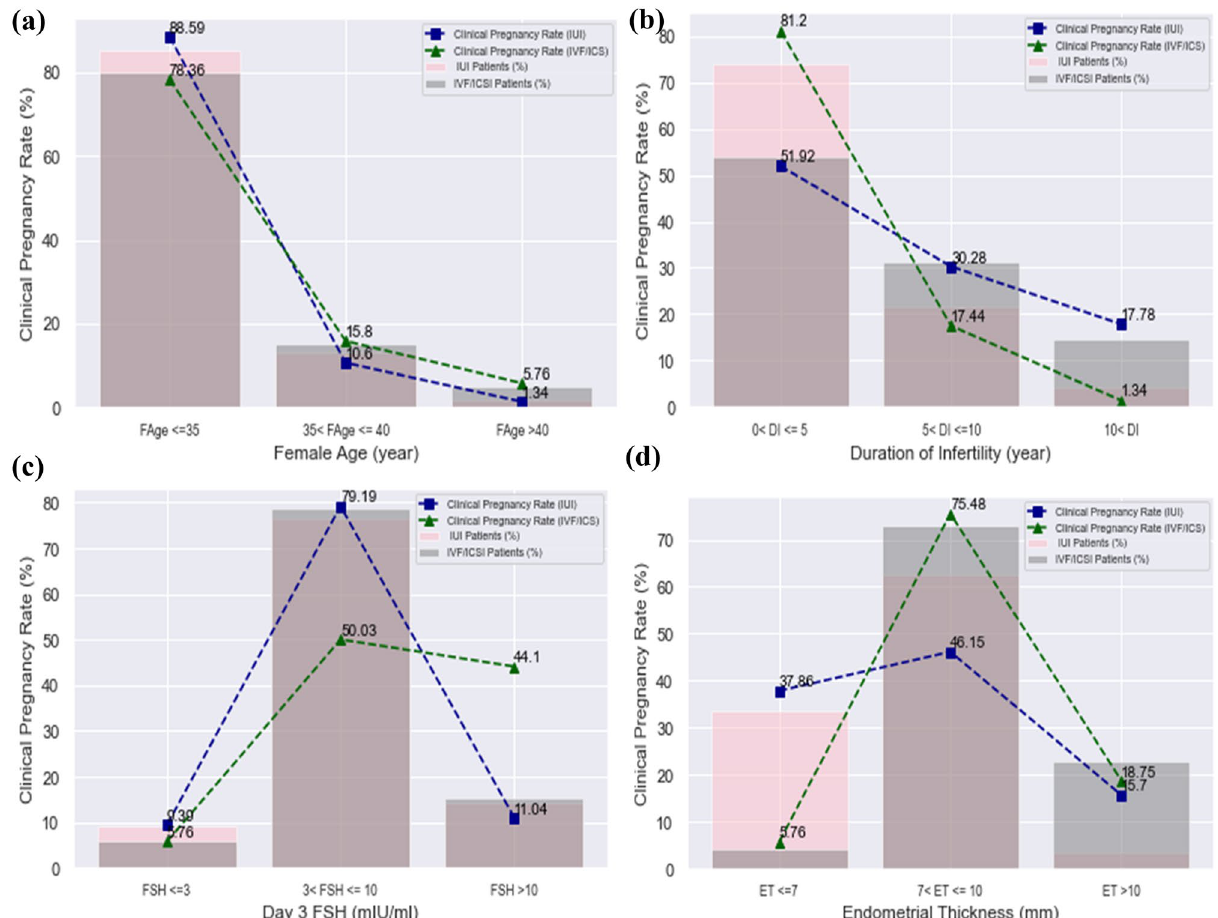
Figure 4. Impact of essential features on CPR based on results of RF model. ( a ) Comparison between CPR and Female Age for IVF/ICSI and IUI datasets, ( b ) Comparison between CPR and Duration of Infertility, ( c ) Comparison between CPR and FSH, ( d ) Comparison between CPR and Endometrial